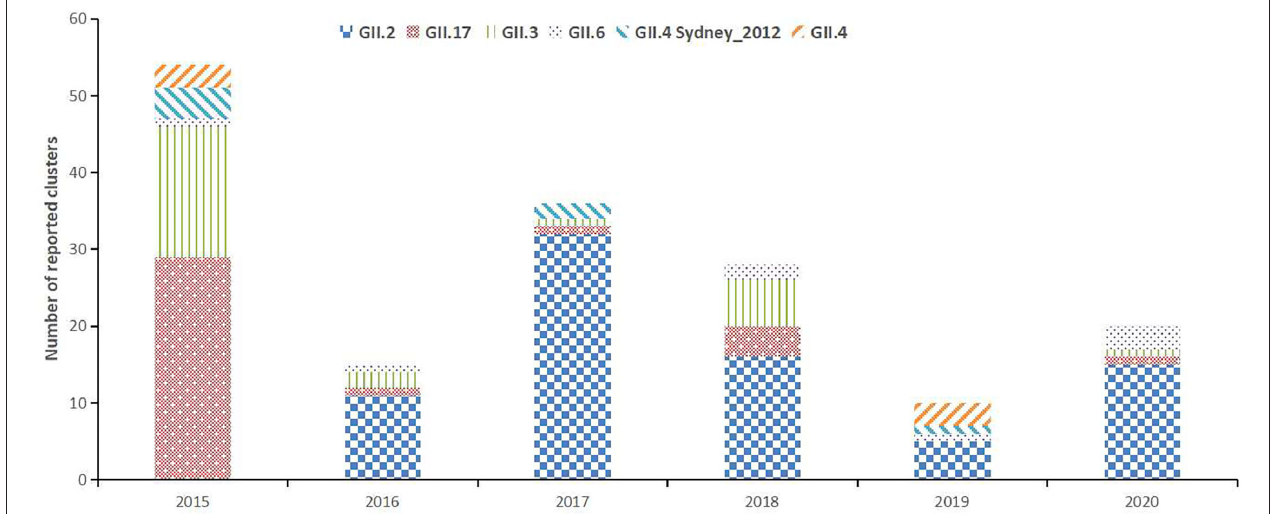
FIGURE 3 | The annual distribution of the molecular genotypes of norovirus clusters in Guangzhou, China, 2015–2020. Columns show the number of cases infected with each